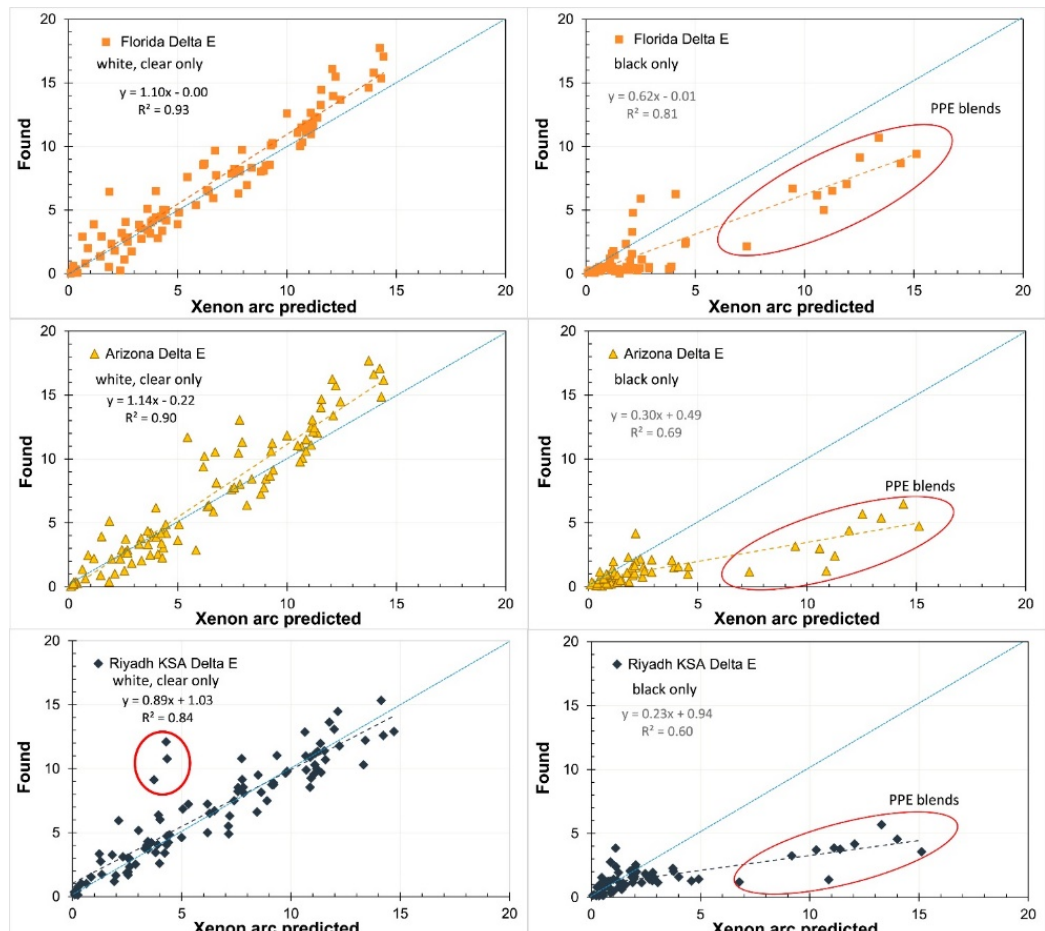
Figure 5. Found vs. predicted color shifts for white and clear materials ( left ) and black materials ( right ). The blue dotted lines show slope = 1 while the colored dashed lines show the linear regression with the equation in the legends. The three circled points on the lower left plot occurred near an abrupt color shift. The circled points on the right side graphs show the PPE blends. Reprinted with permission